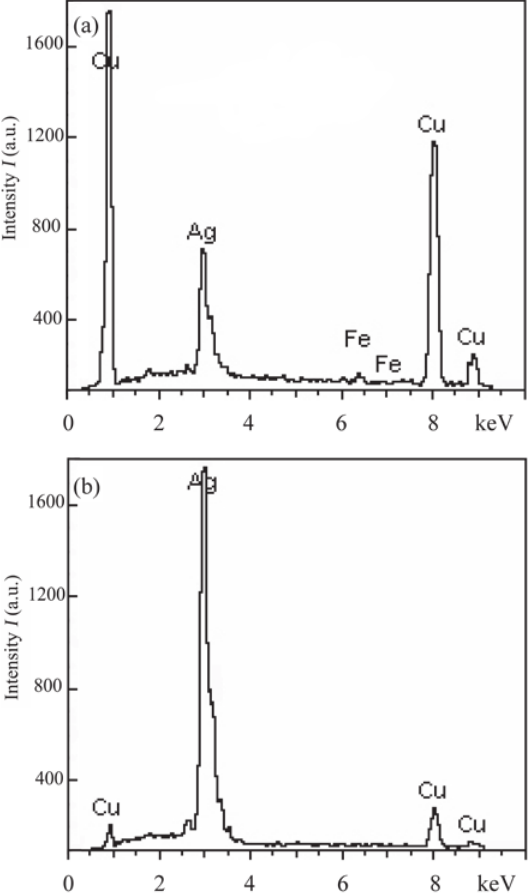
Fig. 3: Microstructure of the brazing joint of W-Cu composite and 1Cr18Ni9 stainless steel